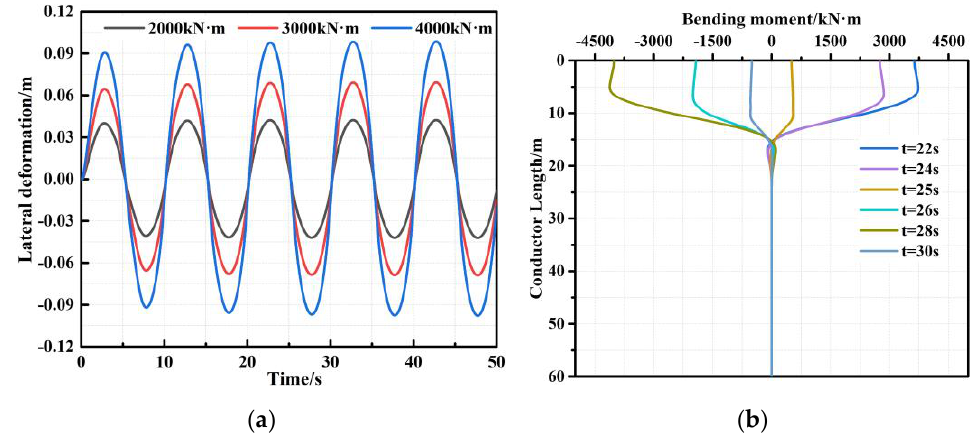
Figure 12. The influence of the bending moment on the mechanical response of the conductor, where ( a ) is the variation of the lateral deformation at the top of the conductor with time and ( b ) is the variation of the bending moment along the conductor axial direction when the maximum bending moment is 4000 kN·m.